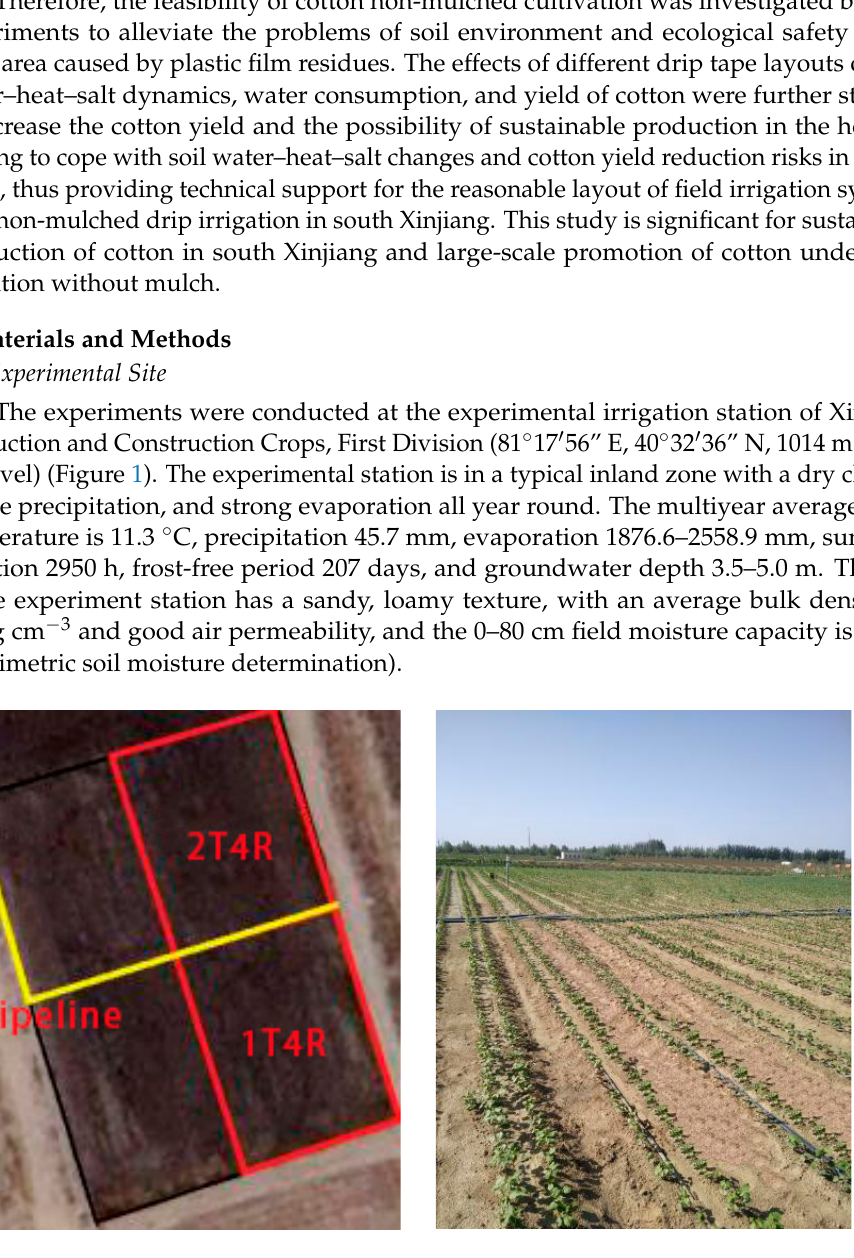
Figure 1. Location of the experimental area and field sampling.